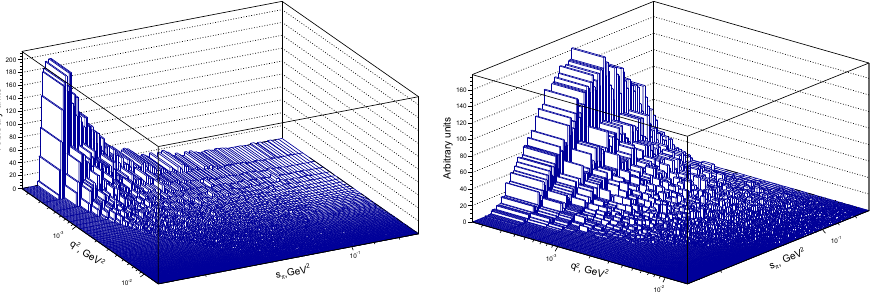
Figure 2. On the left: the full di ff erential decay width with respect to invariants q 2 and S π . On the right: the contribution of DE in the di ff erential decay